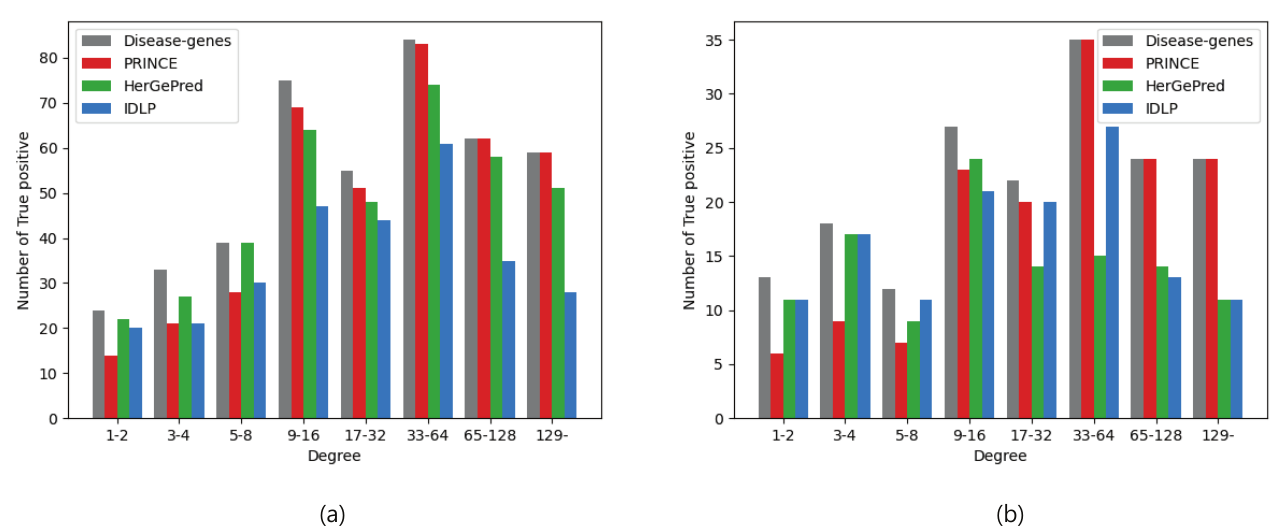
Figure 5. Numbers of disease-associated genes (i.e., ground-truth) and true positives with each method according to their degree in the PPI network in prediction with known disease genes from sample-1 ( a ) and without known disease genes from sample-2 ( b